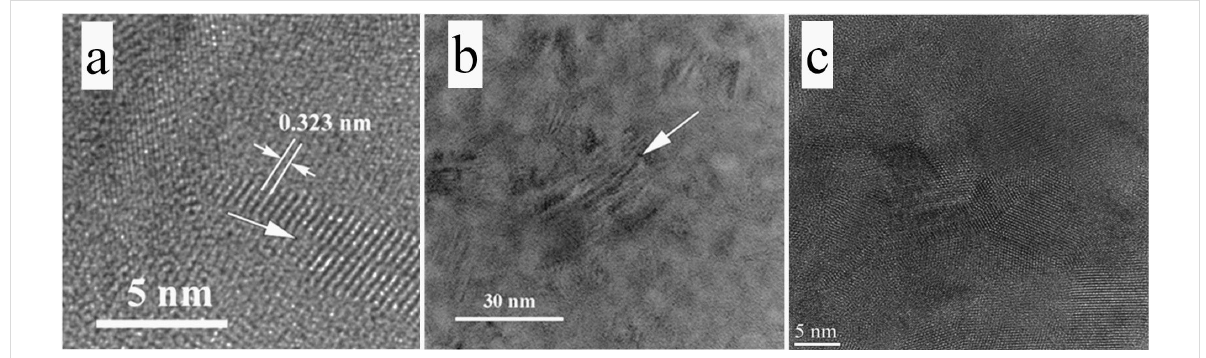
Figure 6: (a) TEM low-magnification image showing the contrast due to the shearing defects appearing in the SiGe crystallites, of a sample annealed at 600 °C for 1 min. (b) High-resolution transmission electron microscope (HRTEM) image showing the lens-like shape of SiGe crystallites as a result of shearing defects. The arrows indicate the shearing planes. (c) Sequence of microtwin bands, observed in a very thin area of the XTEM specimen (MLs with 200 nm thick SiGe [23]). The micrographs in this figure correspond to the structure discussed in our previous study